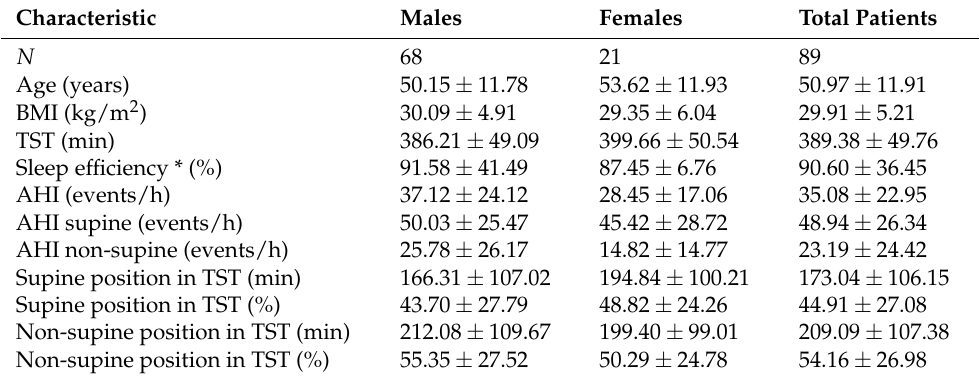
Table 1. Baseline characteristics of study participants and polysomnography data.